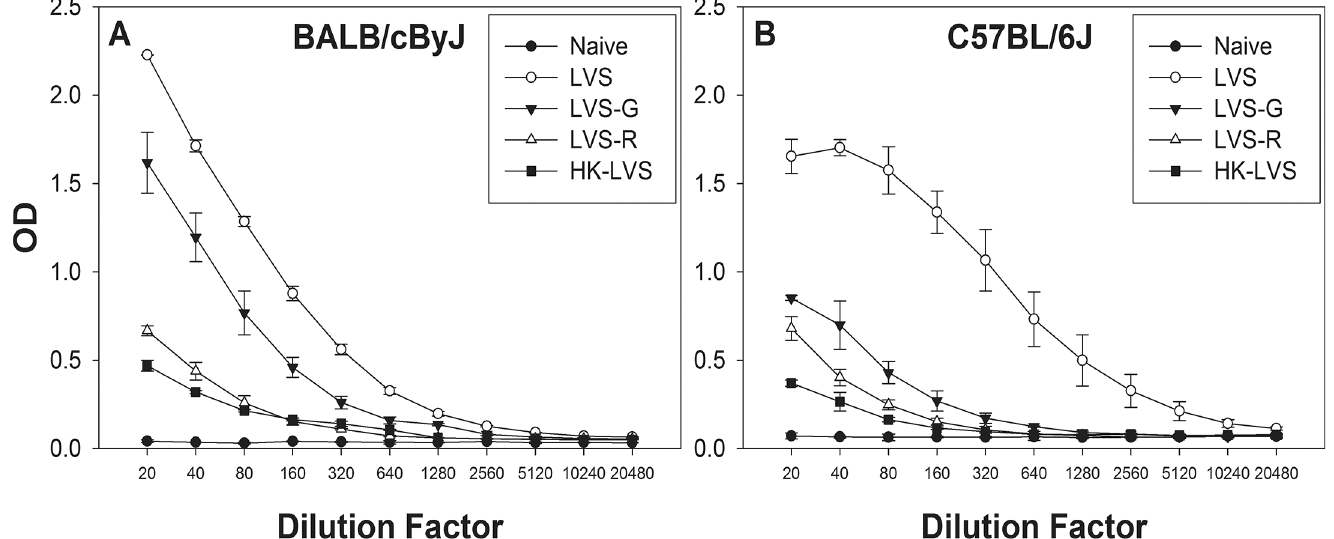
Fig 3. Humoral immune responses patterns to LVS-related vaccines differ between BALB/cByJ and C57BL/6J mice. Pooled sera from five mice for each vaccine group were obtained from BALB/cByJ mice (Panel A) and from C57BL/6J mice (Panel B) six weeks after vaccination, and analyzed for anti- LVS total IgG. Error bars depict standard deviation of the mean of triplicates samples tested in the ELISA. Results shown are from one representative experiment of four independent experiments of similar design and outcome.